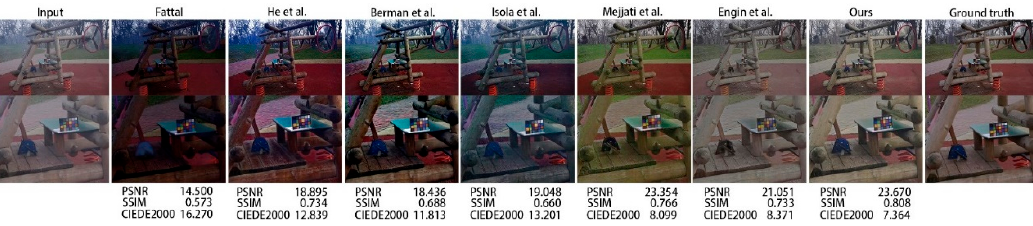
Figure 10. Comparison of the dehazing effects when applied to misty images [3,9,11,12,20,26].